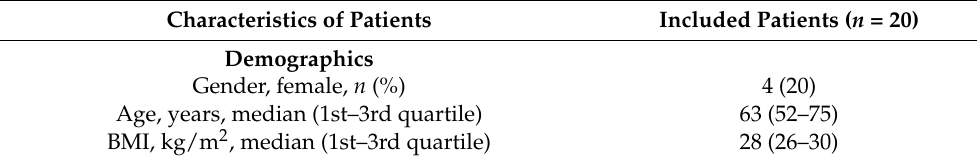
Table 1. Characteristics of the included patients who underwent respiratory physiotherapy. Data are expressed as median (1st–3rd quartile) or number (%) as appropriate. BMI, body mass index; SOFA, sequential organ failure assessment; RPT, respiratory physiotherapy; ICU, intensive care unit; COT, conventional oxygen therapy; PSV, pressure support